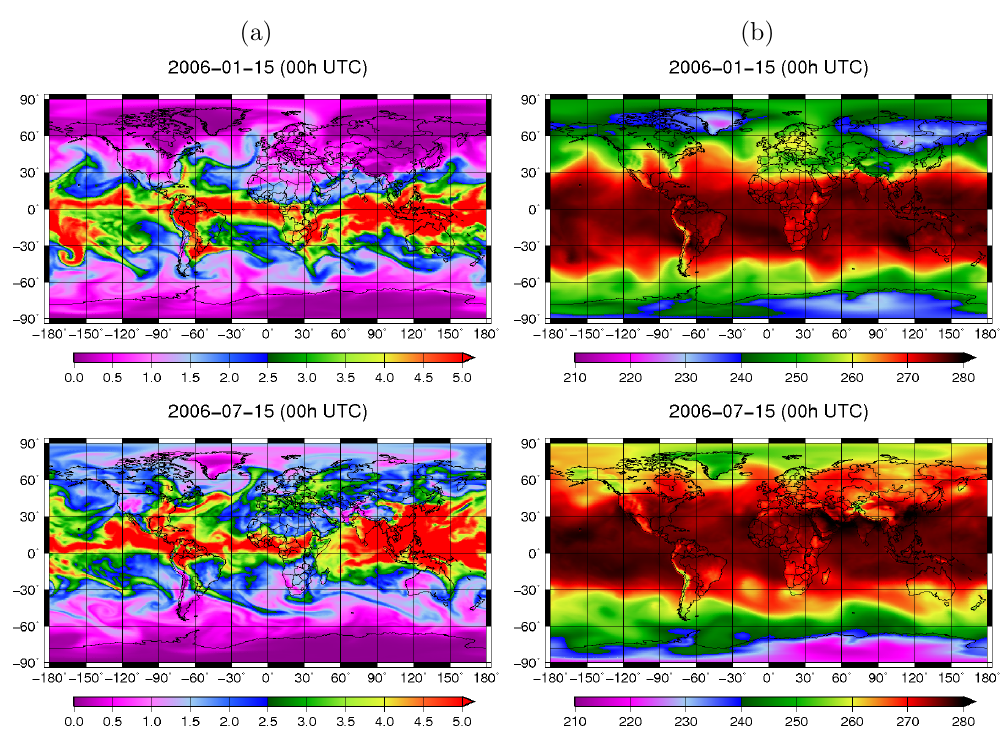
Figure 2. Total column water vapour in precipitable centimetres (a) , and average temperature in the 47–37 sigma-level layer (800–425hPa on the sea) in K (b)